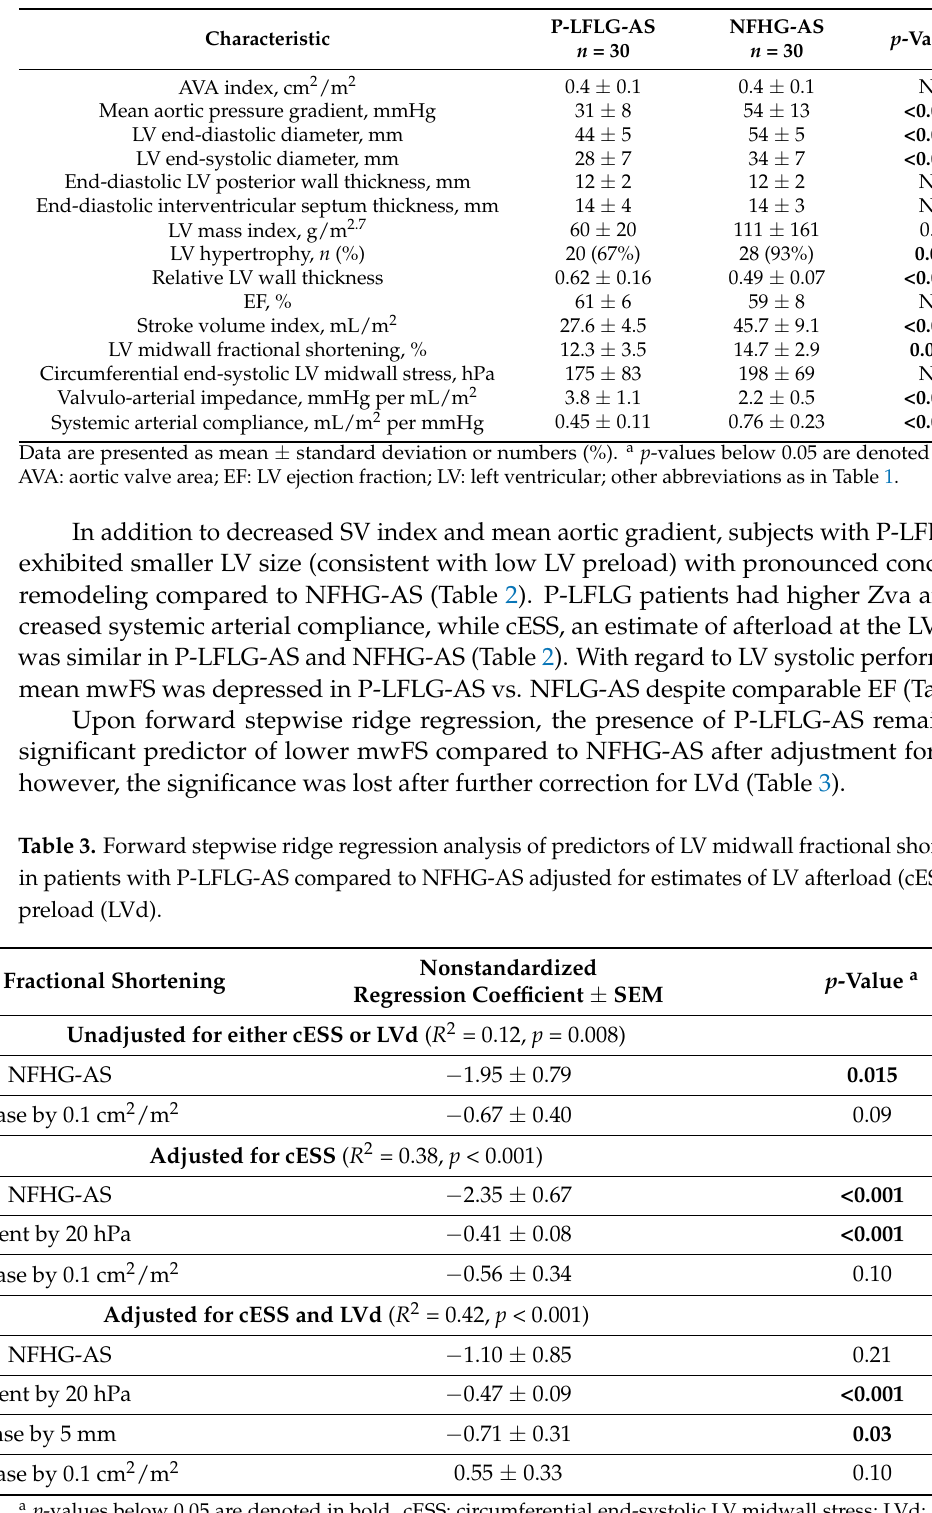
Table 2. Hemodynamic characteristics of patients with P-LFLG-AS vs. NFHG-AS.